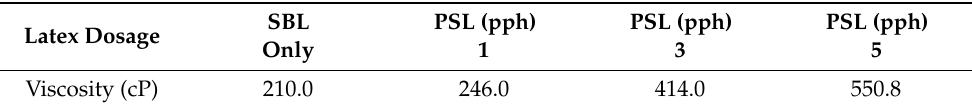
Table 4. Effect of the PS latex cobinder on the viscosity and dewatering of coating